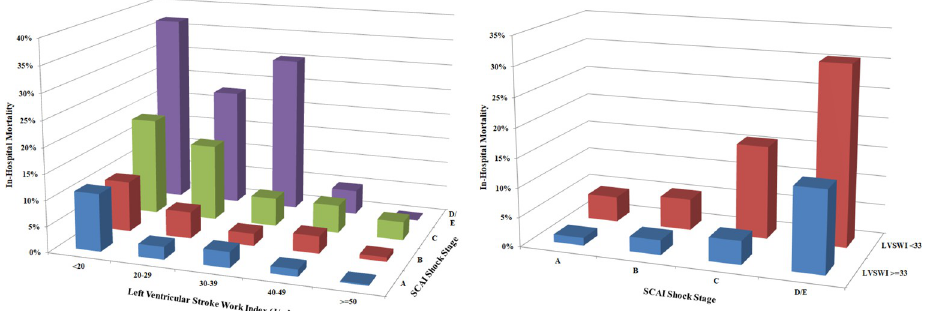
Fig 4. In-hospital mortality as a function of SCAI shock stage stratified by ECHO-LVSWI group (left) and for patients with ECHO-LVSWI < or � 33.1 J/m 2 (right).